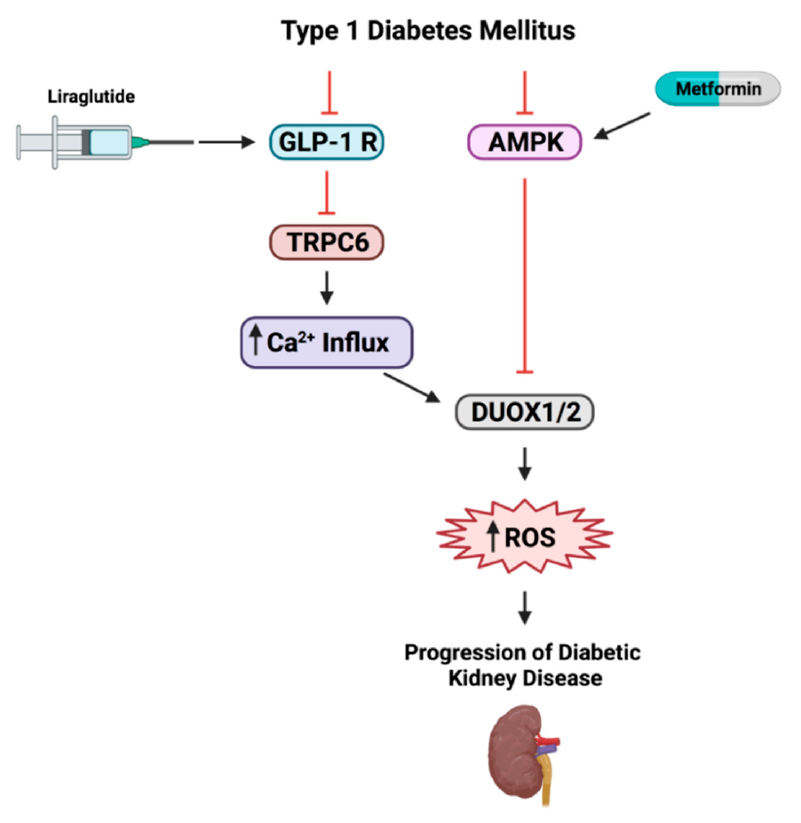
Figure 6. Graphical abstract. The reno-protective effect of liraglutide is mediated by the inhibition of TRPC6/NADPH oxidases-DUOX1 and 2-ROS production signaling pathways. However, metformin reno-protective effect is mediated by damping NADPH oxidases-DUOX1 and 2-ROS production axis through AMPK activation independently from TRPC6.